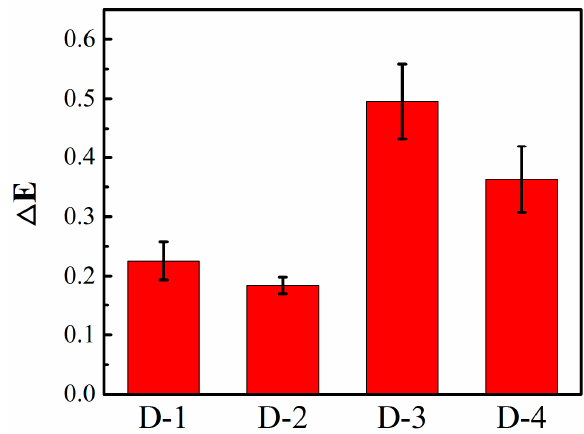
Figure 12. Levelling properties of wool / acrylic blended fabrics with heterocyclic dyes.